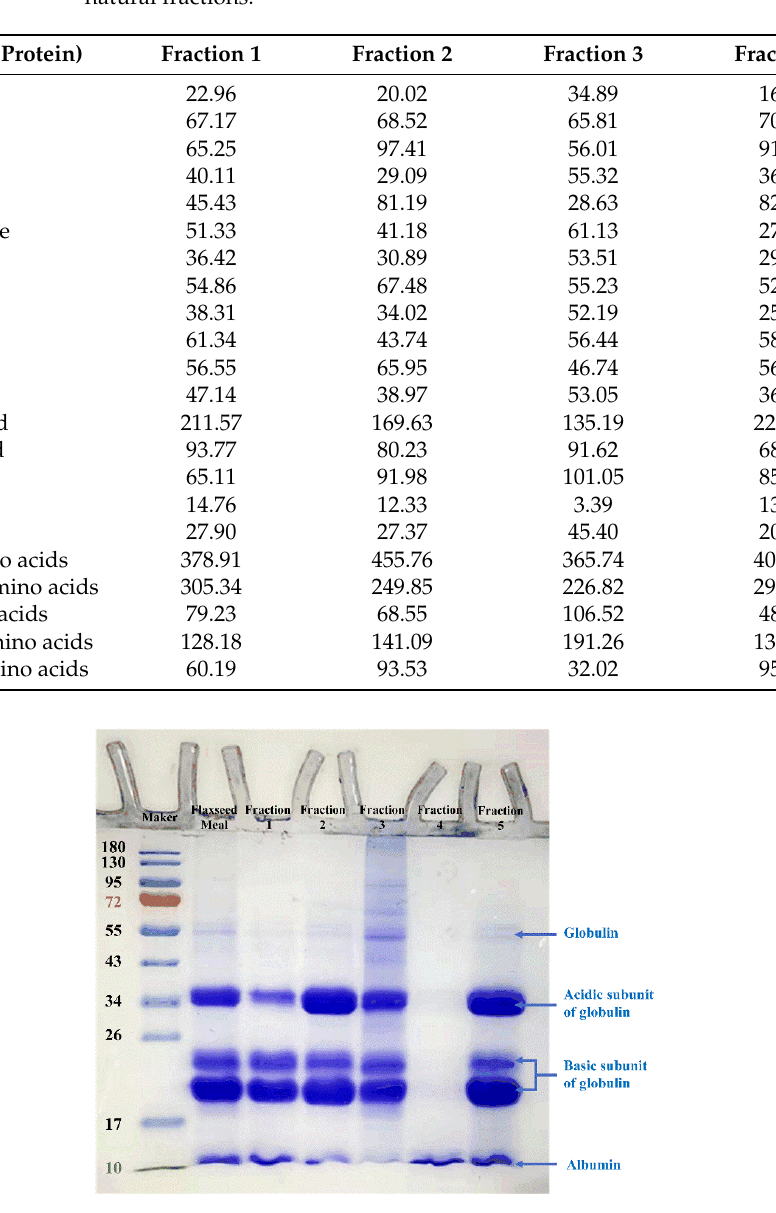
Figure 2. SDS-PAGE profiles of the defatted flaxseed meal and protein-polysaccharide natural frac- tions under reducing